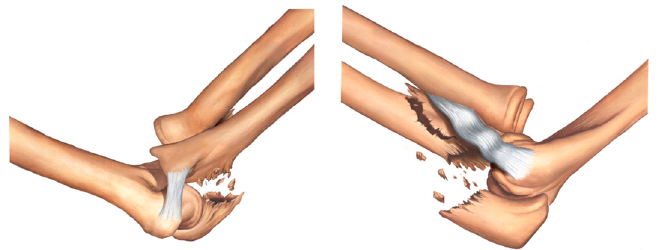
Figure 5. Type IIB fracture—transolecranon fracture of the proximal ulna with associated fracture of the sublime tubercle and coronoid process.